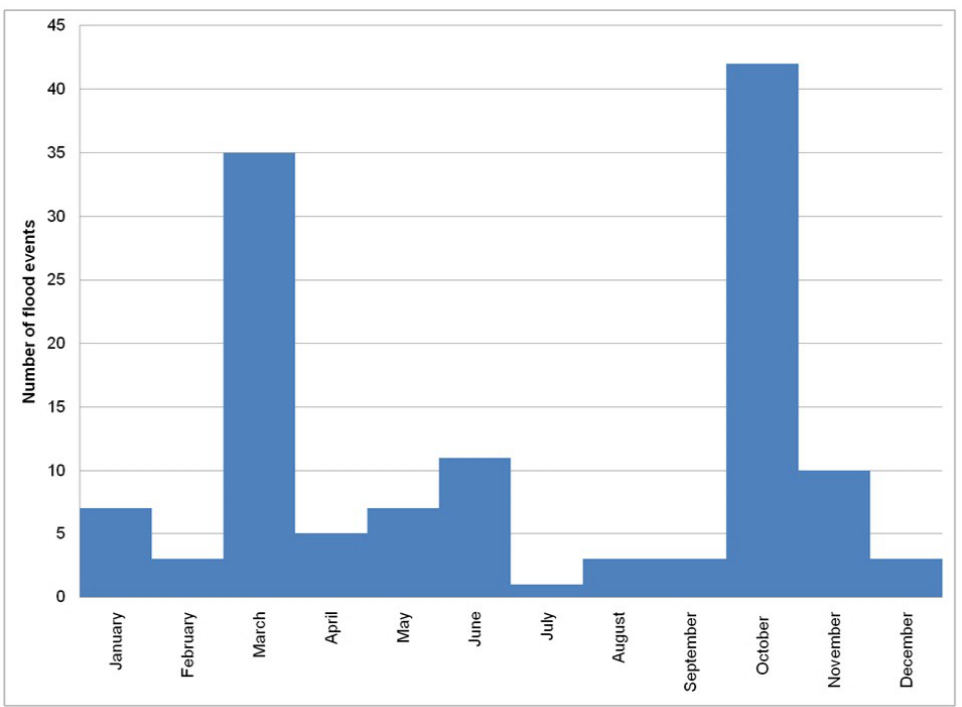
Figure 5. The monthly distribution of flood events during